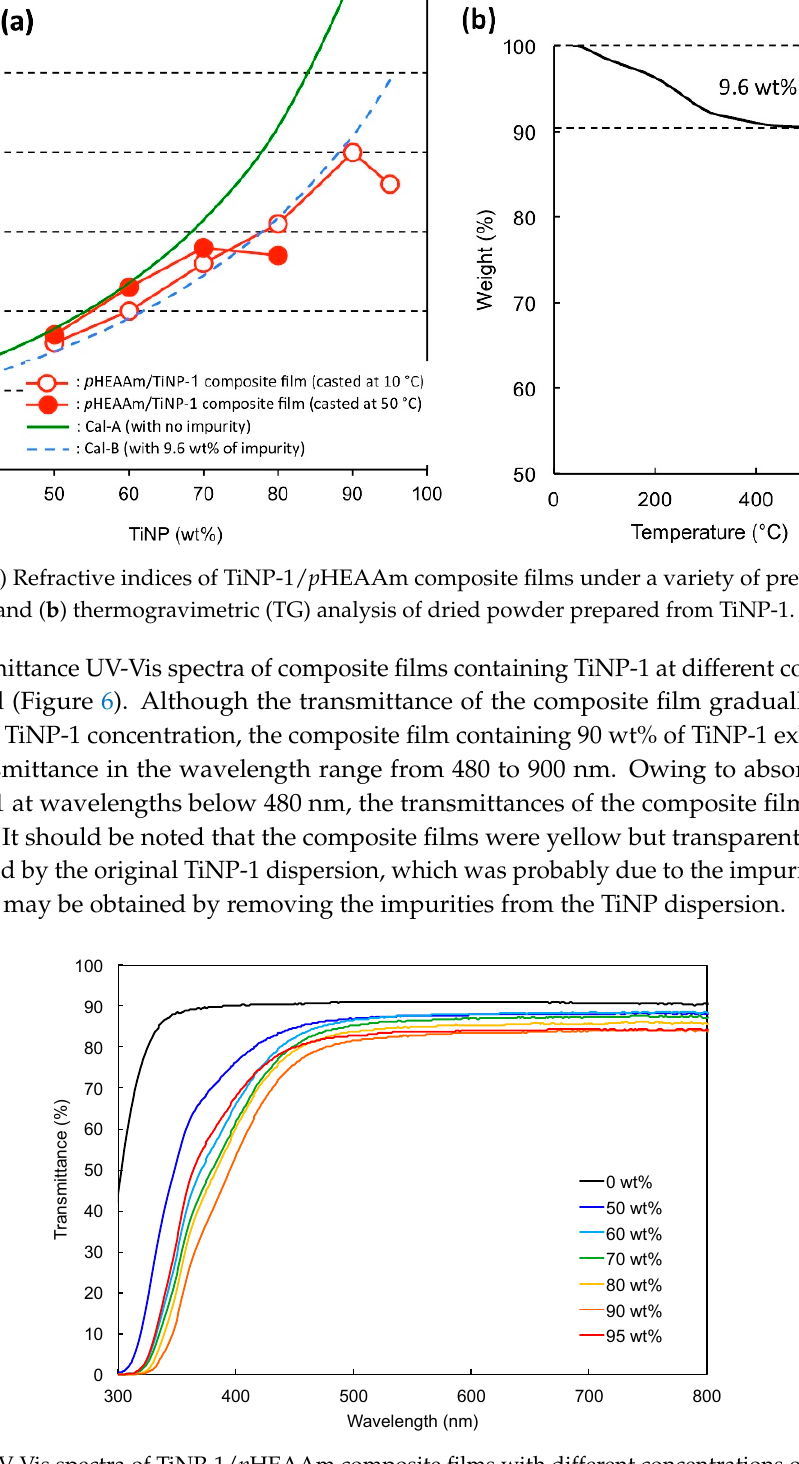
Figure 6. UV-Vis spectra of TiNP-1/ p HEAAm composite films with different concentrations of TiNP-1. The composite films were prepared by drop casting the aqueous mixture of TiNP-1 and p HEAAm on a glass plate and drying at 10 °C.